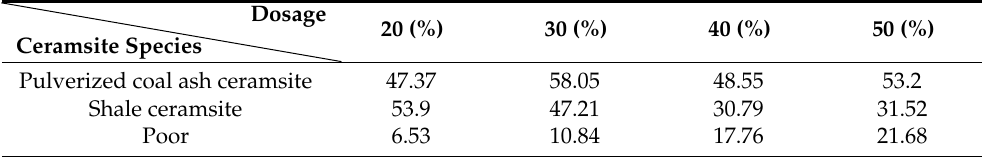
Table 4. Analysis of the 14 − day compressive strength of concrete.